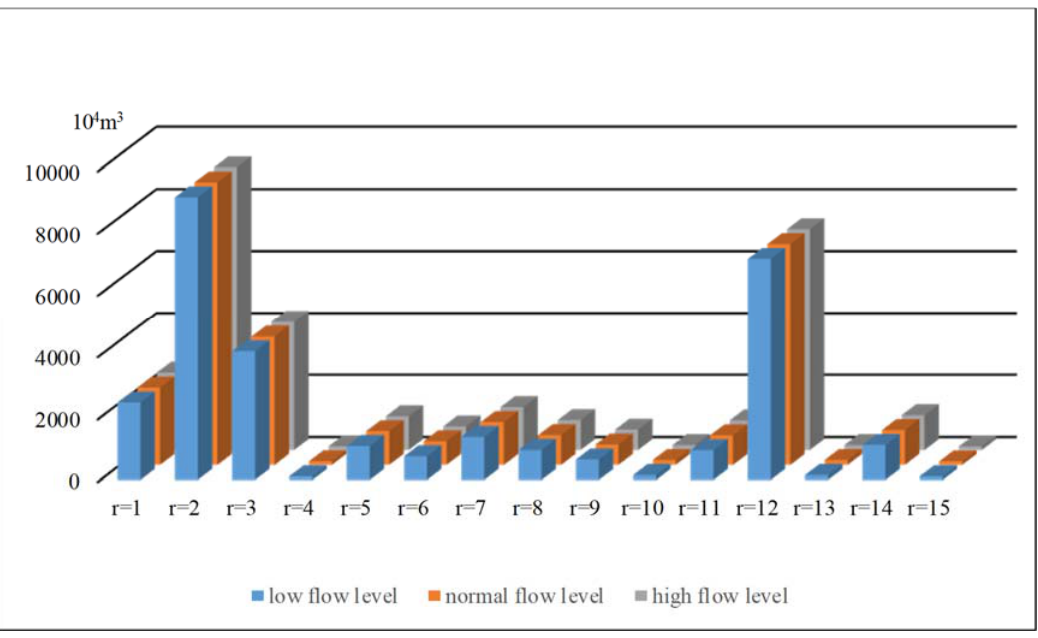
Figure 8. Water diversion schemes of local resources under different levels. Water 2019 , 11 , x FOR PEER REVIEW